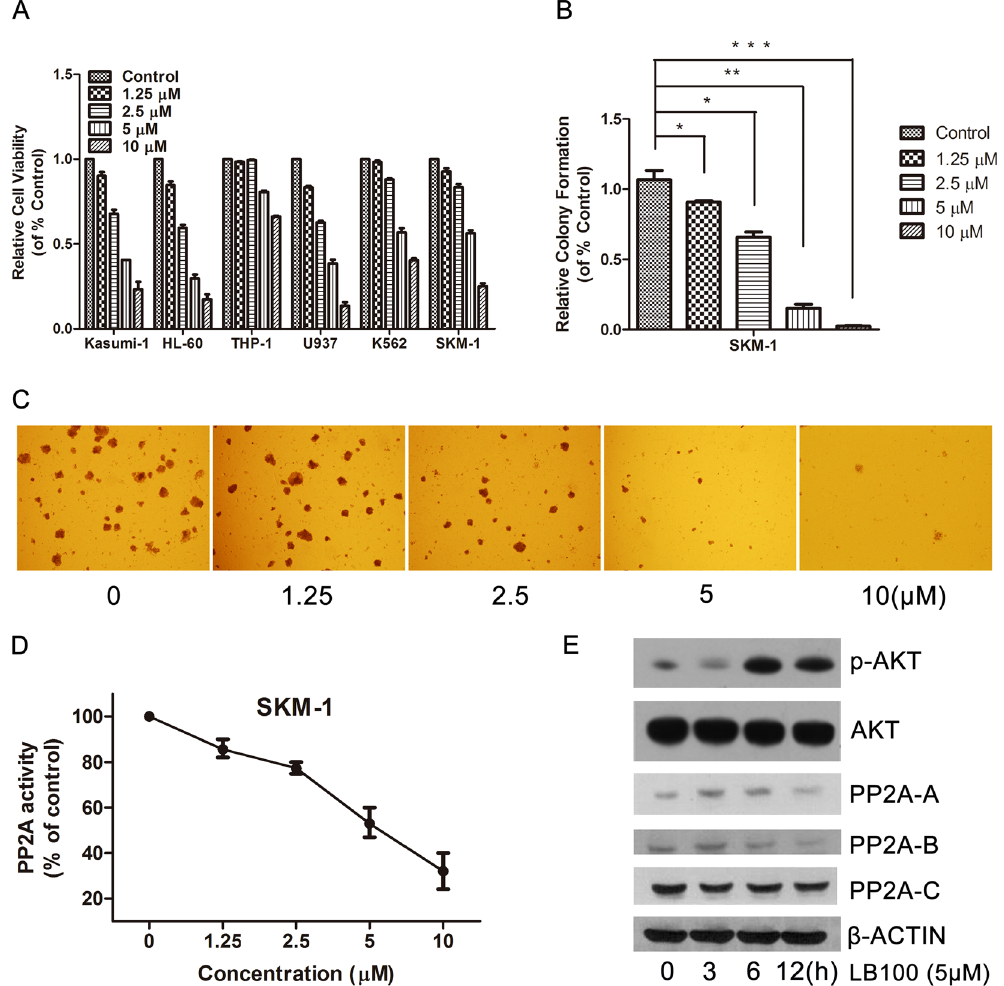
Figure 1. Inhibition of PP2A by LB100 decreases AML and sAML cell proliferation. ( A ) LB100 decreased cell proliferation in multiple leukemia cell lines in a dose dependent manner. ( B , C ) SKM-1 colony formation rate significantly decreased following LB100 treatment in a concentration dependent fashion after 7 days of culture in methylcellulose medium. Images were obtained at x40 magnification. ( D ) After 6 hours of LB100 treatment, PP2A activity was decreased with increasing concentrations of LB100 in SKM-1 cells. ( E ) PP2A isoform levels were moderately decreased after receiving 5 μ M LB100 treatment for 12 h. Statistically significant differences are marked by an asterisk ( * P < 0.05; ** P < 0.01, *** P ≤